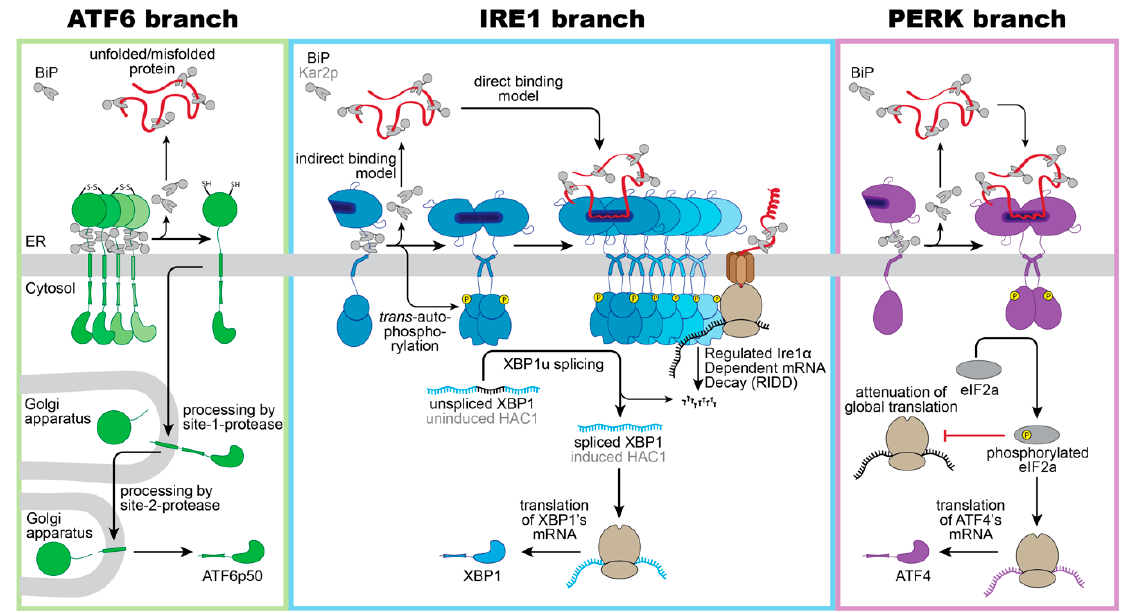
Figure 1. Schematic overview of proteotoxic ER stress signaling by the UPR. Three branches of the UPR sense proteotoxic stress in the ER to control adaptive transcriptional and non-transcriptional responses: ATF6, IRE1 (IRE1 α in mammals/ ScIRE1 in S. cerevisiae ) and PERK. ( Left panel ): Intermolecular disulfide bonds stabilize inactive homo-oligomers of ATF6 thereby limiting the pool of ATF6 that can be activated. In the absence of ER stress, ATF6 interacts with its negative regulator BiP. Notably, various regions of the ER-luminal domain of ATF6 contribute to BiP binding, but only a membrane-proximal binding region is indicated here for simplicity. Current models suggest a dissociation of BiP from ATF6 upon ER stress. The unmasking of Golgi localization signals allows for packaging of ATF6 into COPII vesicles for a transport to the Golgi apparatus. Processing by the site ‐ 1 ‐ protease and site ‐ 2 ‐ protease releases a transcriptionally active fragment (ATF6p50) for regulating UPR target genes in the nucleus. ( Middle panel ): Inactive monomers of IRE1 α /ScIre1 associate with BiP/Kar2p via various interaction sites. Proteotoxic ER stress causes a dimerization of IRE1 α /ScIre1, the release of BiP/Kar2p, and the formation of higher oligomeric assemblies of IRE1 α /ScIre1. The enforced proximity of the cytosolic effector domains enables a trans ‐ autophosphorylation of the cytosolic kinase domain and activation of the RNase domain. Oligomers of IRE1 α and ScIre1 cleave the mRNA of unspliced XBP1 and uninduced HAC1 , respectively, as the committed step for unconventional splicing. Translation of the spliced mRNA yields an active transcription factor XBP1/HAC1 up ‐ regulating hundreds of UPR target genes in the nucleus. Oligomers of the mammalian IRE1 α oligomers can reduce the load of the ER with unfolded proteins via the regulated IRE1 α‐ dependent mRNA Decay (RIDD). ( Right panel ): Proteo ‐ toxic ER stress causes a dissociation of BiP from PERK and facilitates the formation of PERK dimers and oligomers. Trans ‐ autophosphorylation activates PERK’s cytosolic kinase domain, which then phosphorylates the eukaryotic initiation 2 α (eIF2 α ). This causes a global attenuation of translation, but also selectively promotes the production of the transcription factor ATF4. ATF4 controls both pro ‐ survival and pro ‐ apoptotic signals.